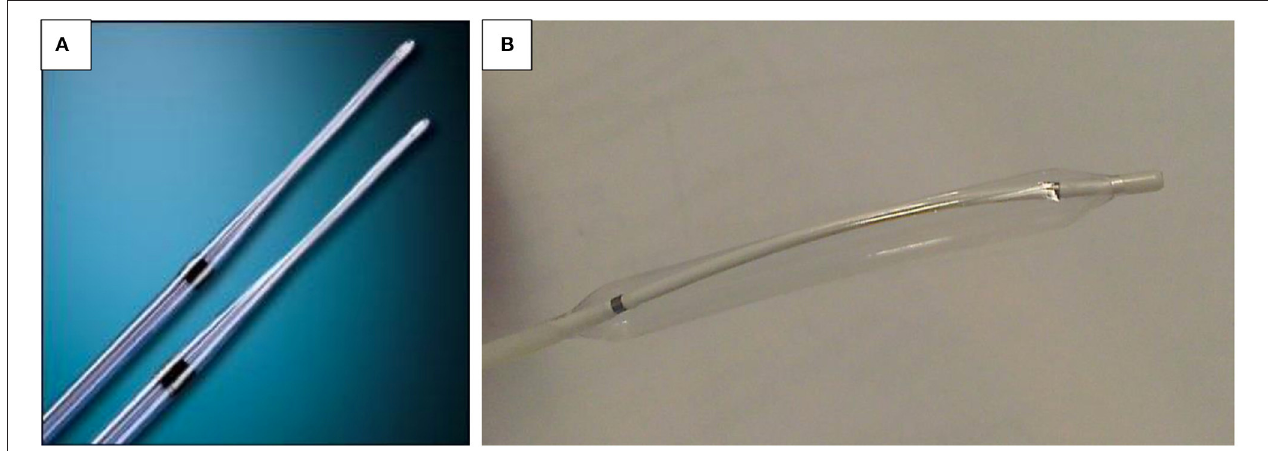
FIGURE 8 | (A,B) Dilatation device. (A) Bougie dilator (Savary-Gilliard). (B) Balloon